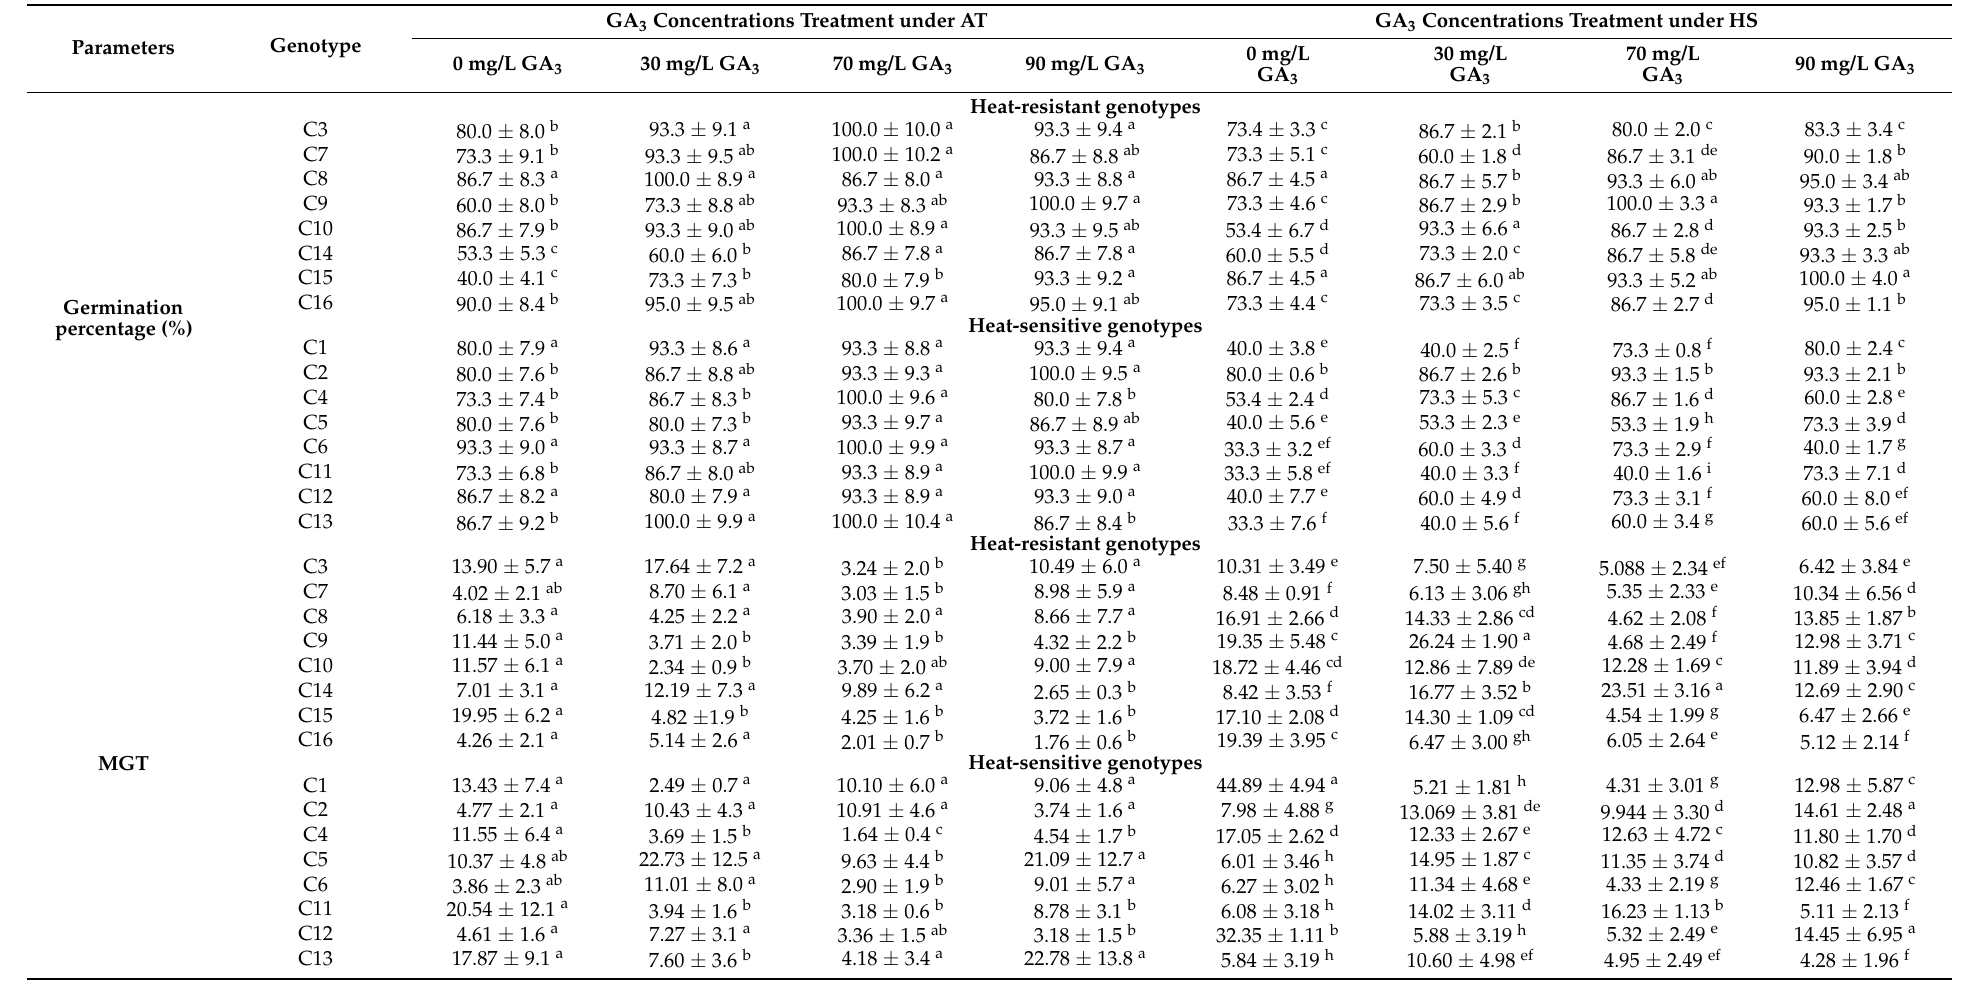
Table 1. Effects of GA 3 concentrations (mg/L) on germination parameters of the selected heat-resistant and heat-sensitive Cyclamen genotypes under ambient temperatures and heat